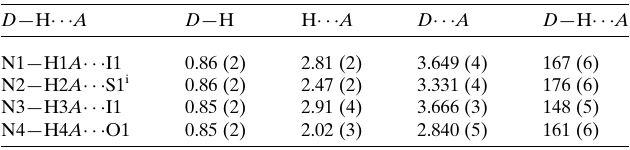
Table 2 Hydrogen-bond geometry (A˚ , (cid:4) ) for (2).